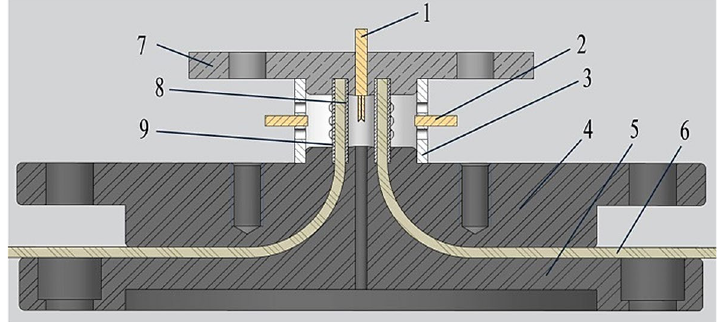
Figure 3. Installation layout of the load configuration in CQ3-Shot137. (1. internal photonic Doppler velocimetry probes 2. external photonic Doppler velocimetry probe 3. probe support 4. anode flange 5.